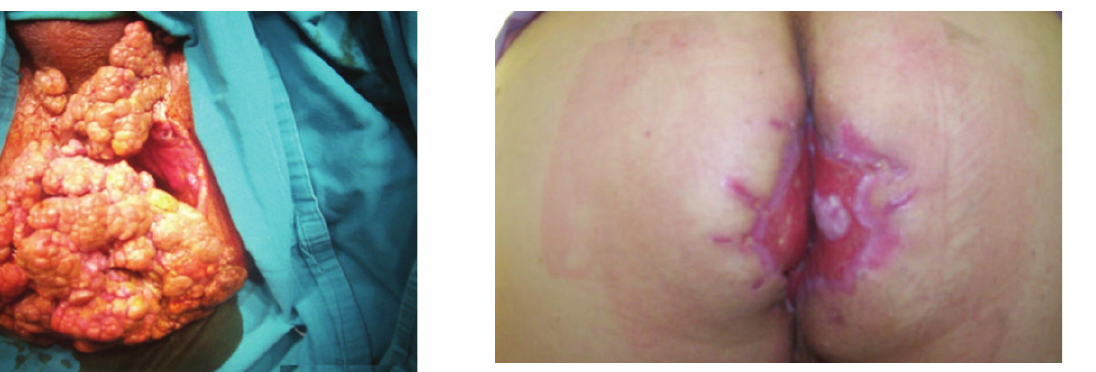
Figure 3: The image after healing of the